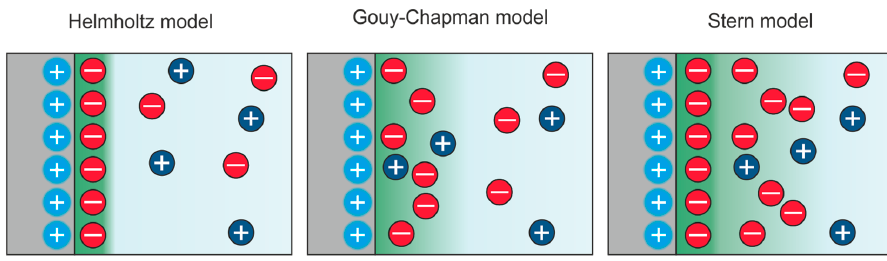
Figure 4. Models of the formation of the electrical double layer in an electrolyte in contact with a positively charged solid electrode. positively charged solid